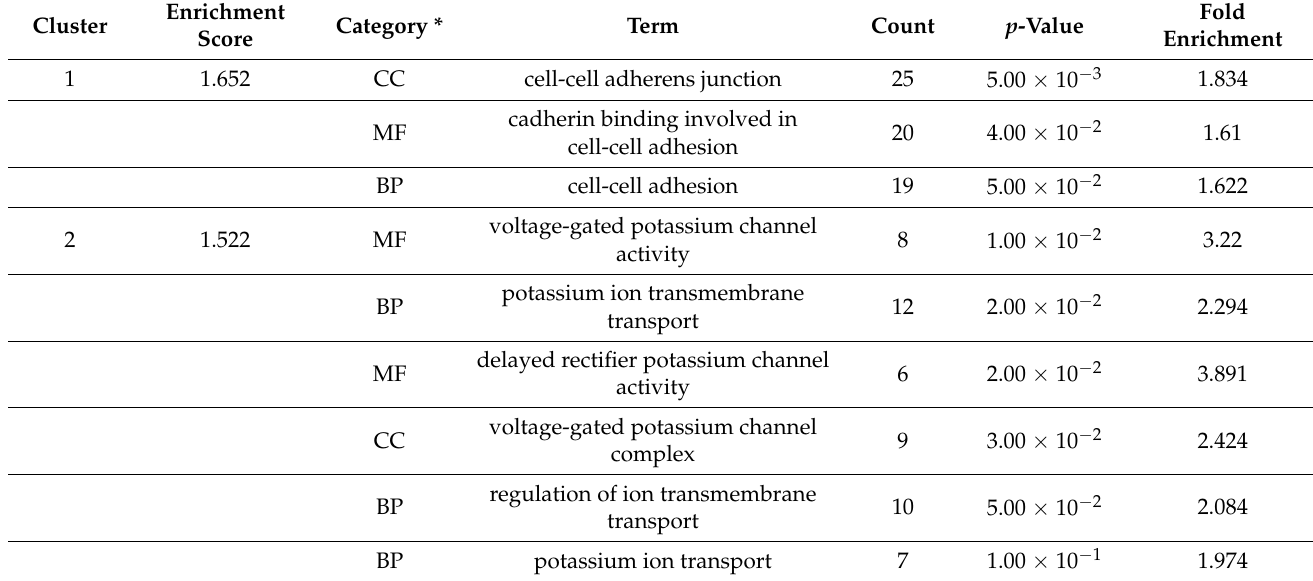
Table 3. Top five enriched functional gene ontology (GO) of